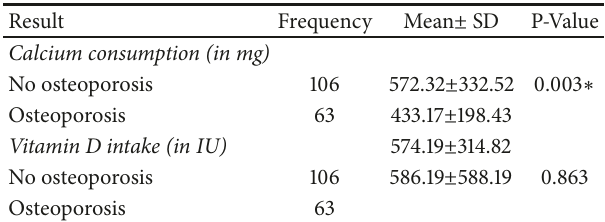
Table 5: Dietary association with